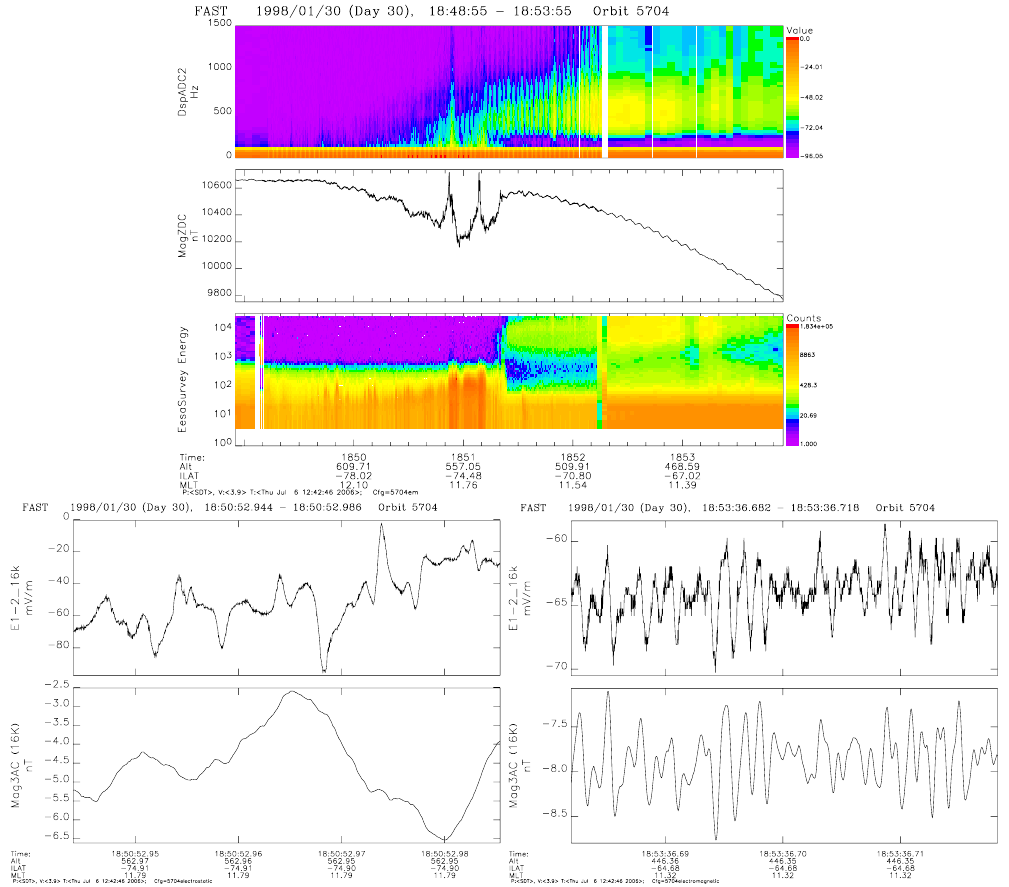
Fig. 2. The center-top panels show the electric field power spectrum, DC magnetic field perturbations along the spin axis, and electron energy spectra (in eV). The left-bottom panels show the V1-2 signal and the AC spin axis magnetic field perturbations from 0.04s interval. The time of these left-bottom panels corresponds to the location of one of the two intense DC magnetic field perturbations shown in the center-top panels. The bottom-right panel shows the same signals as the bottom-left panels show, except that the time interval corresponds to a location in the hard ( > 1keV) electron precipitation period of the center-top panels and away from DC magnetic field